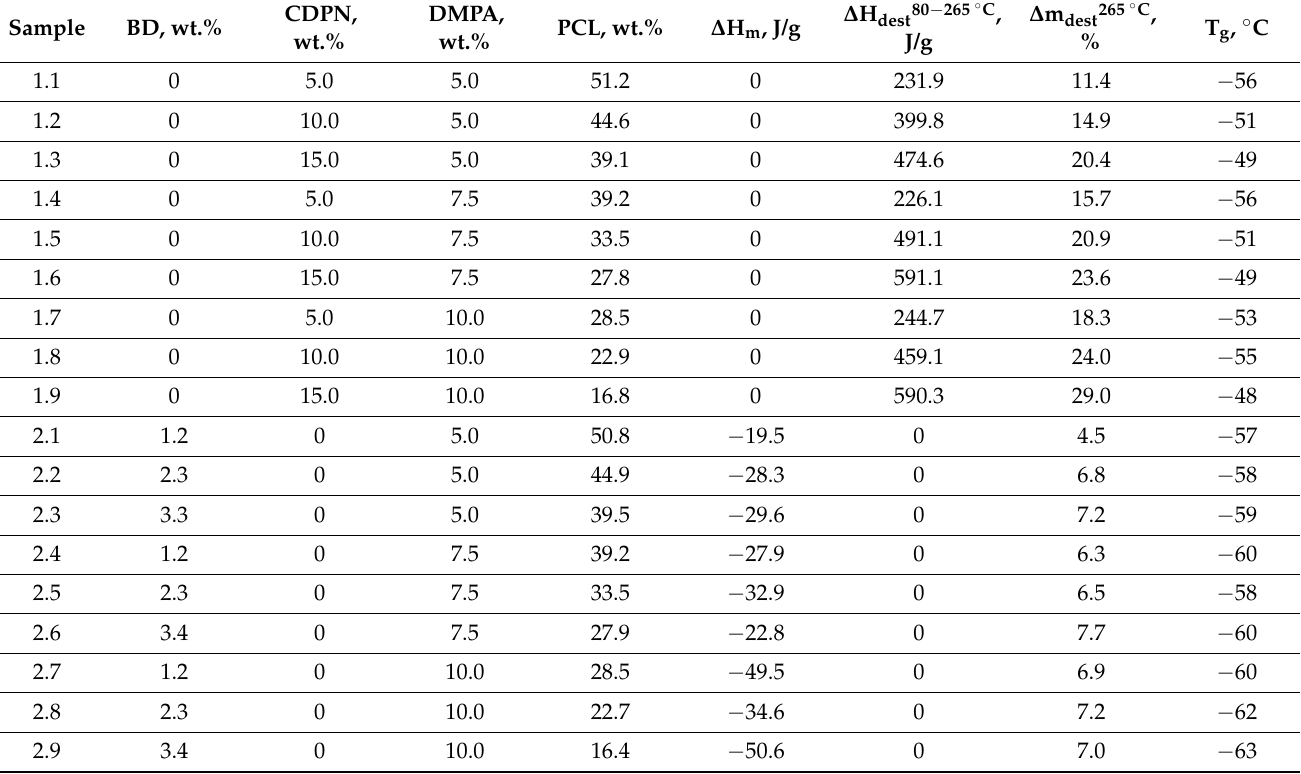
Table 5. Thermophysical and thermochemical characteristics of WPU